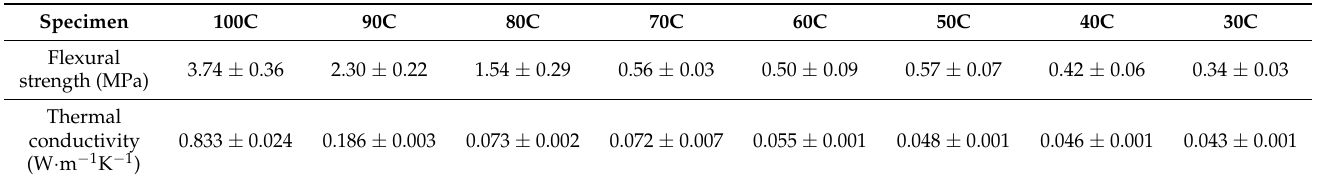
Table 4. Flexural strength and thermal conductivity for all